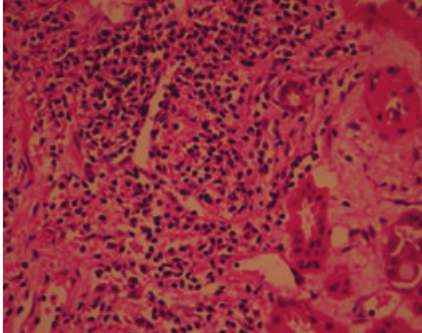
Figure 5: Acute interstitial